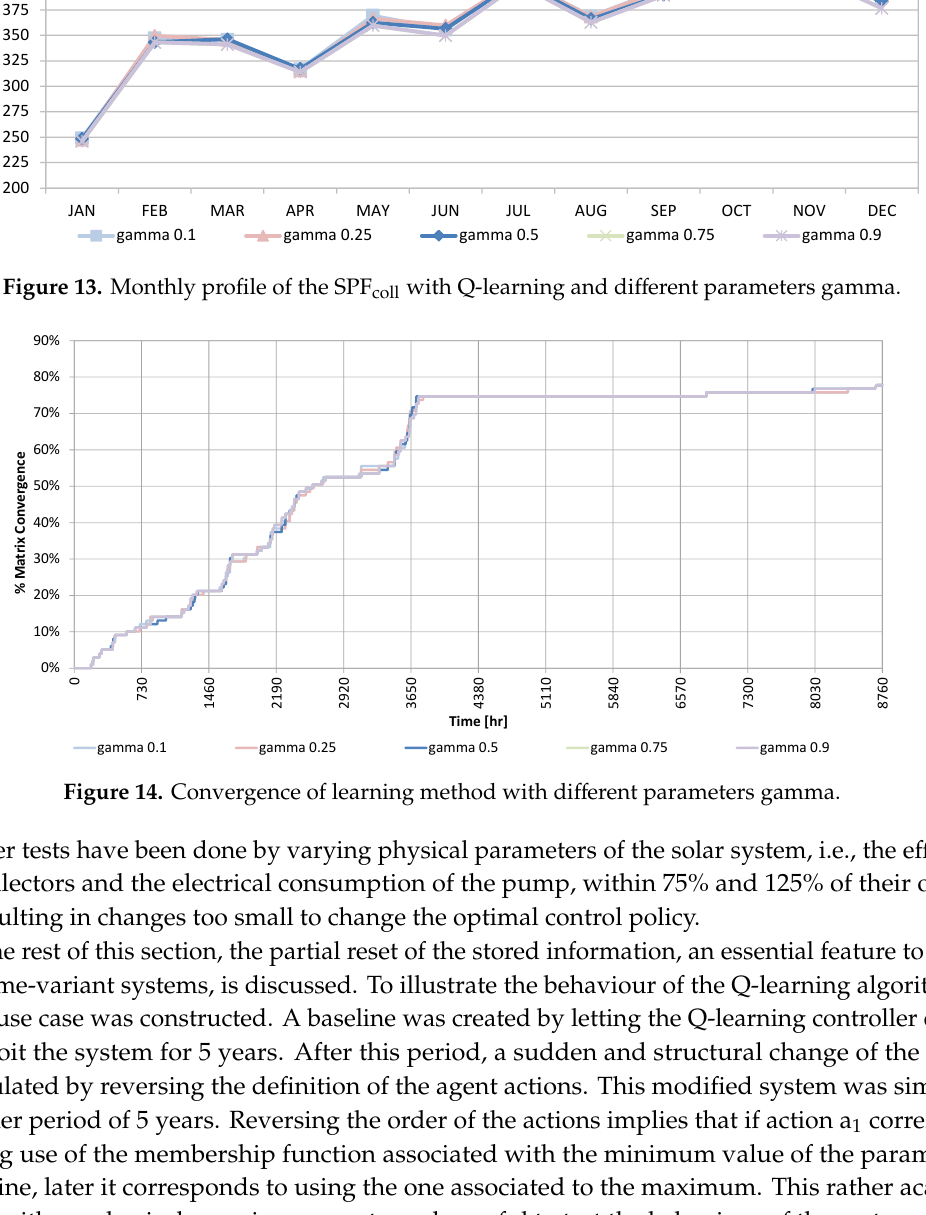
Figure 12. Convergence of the learning using